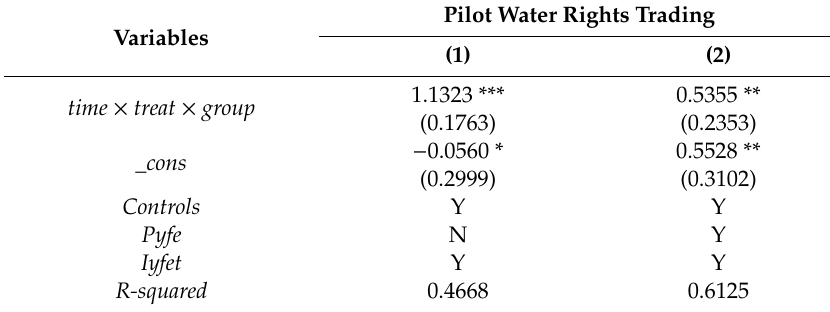
Table 6. Concurrent event